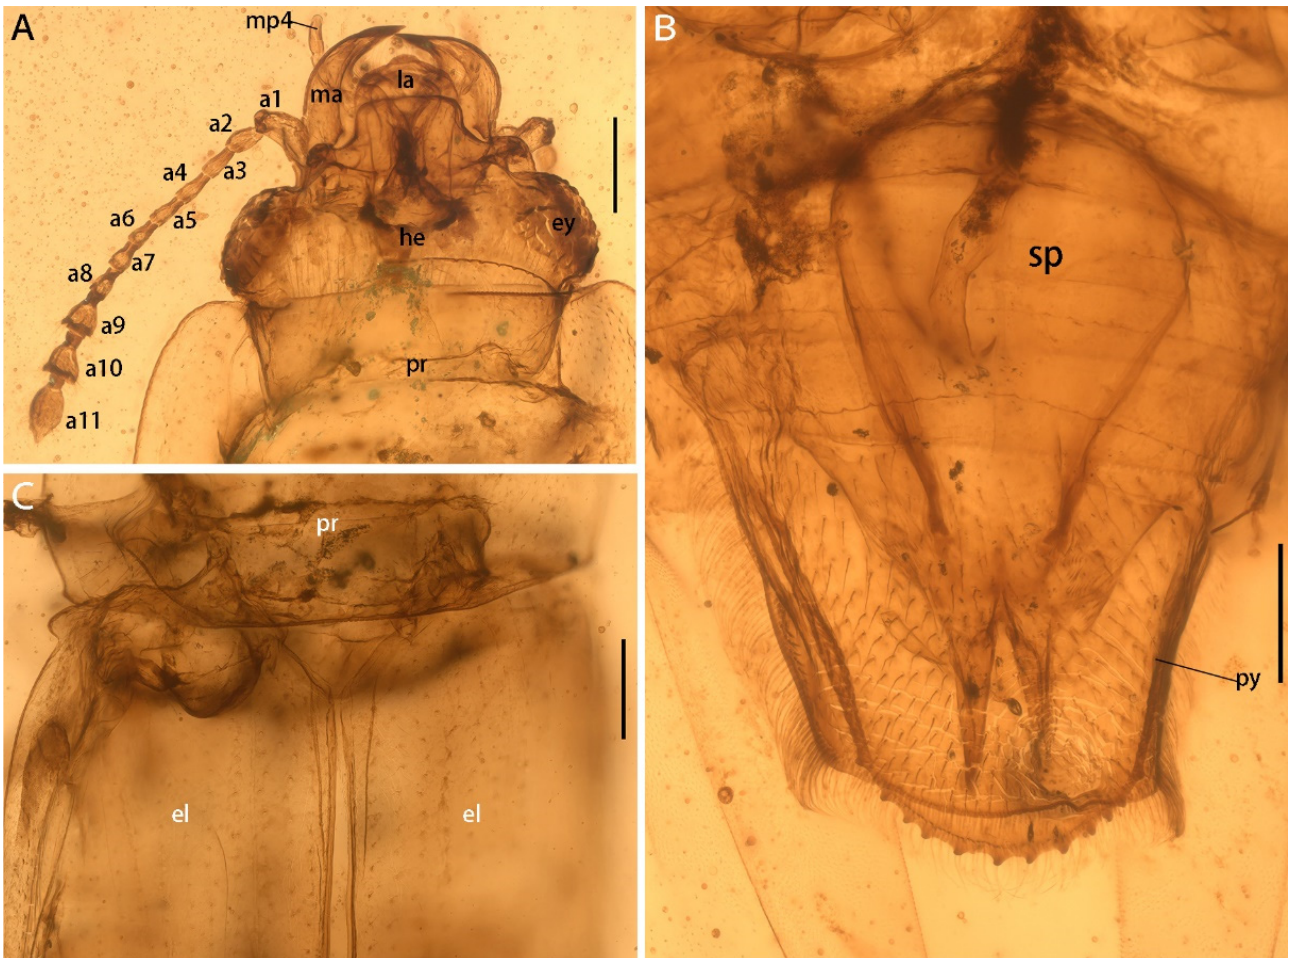
Figure 2. Morphological details of Protonitidula neli gen. et sp. nov. from mid-Cretaceous Burmese amber under transmitted light (holotype, NIGP200399). ( A ) Dorsal view of head. ( B ) Pygidium with spermatheca. ( C ) Basal part of elytra. Abbreviations: he, head; ma, mandible; ey, eye; pr, pronotum; mp4, maxillary palpomere 4; la, labrum; el, elytra; a1–11, antennomere 1–11; py, pygidium; sp, spermatheca. Scale bars: 200 μ m.